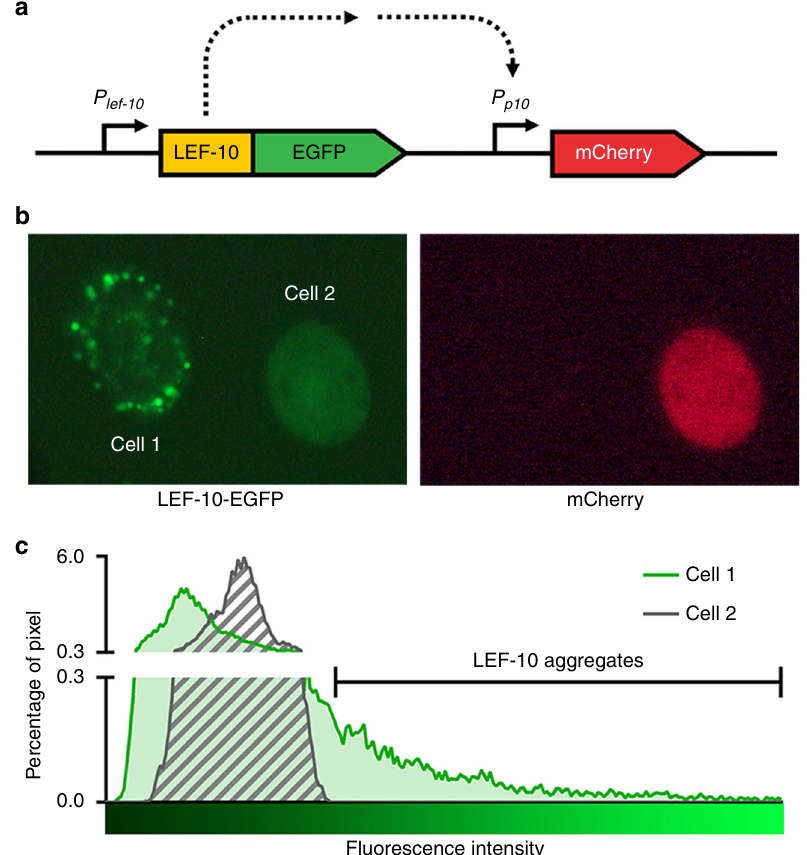
Fig. 1 LEF-10-EGFP forms aggregates in infected insect cells. a Diagram of the recombinant baculovirus sensor system functions by transmitting the aggregation state of LEF-10-EGFP to downstream gene reporter mCherry outputs. The cassette fragment was integrated into the polh locus of a lef-10 knock-out Bacmid via site-speci fi c homologous recombination (Supplementary Fig. 1a). b LEF-10-EGFP exists in two distinct forms: as aggregated (Cell 1) or as diffuse (Cell 2) forms in infected insect cells (MOI = 3) at 60 hpi (left). The mCherry reporter protein representing late gene expression can only be detected in cells harboring diffuse LEF-10-EGFP (right). c The distribution of LEF-10-EGFP in the two cells (b, left) was analyzed by ImageJ software. The proportion of the pixels of a certain brightness to all the pixels harbored by one cell is de fi ned as “ percentage of pixel ” . Higher fl uorescence intensity, which leads to the curve shifting to the right in Cell 1, indicates the aggregation of LEF-10-EGFP and exhausts the pool of non-aggregated LEF-10-EGFP which occurs in the lower fl uorescence intensity